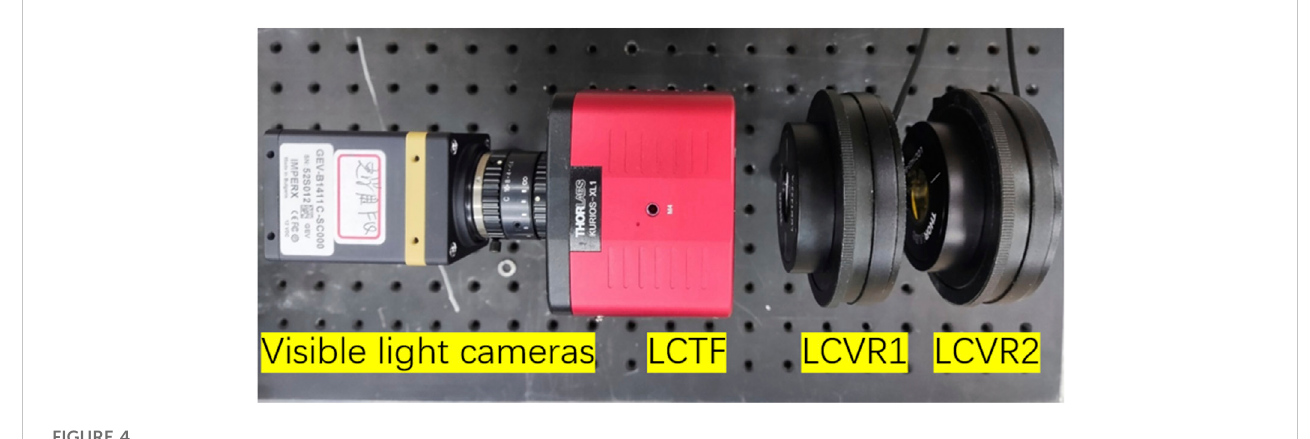
FIGURE 4 Spectral polarization imaging experimental setup.